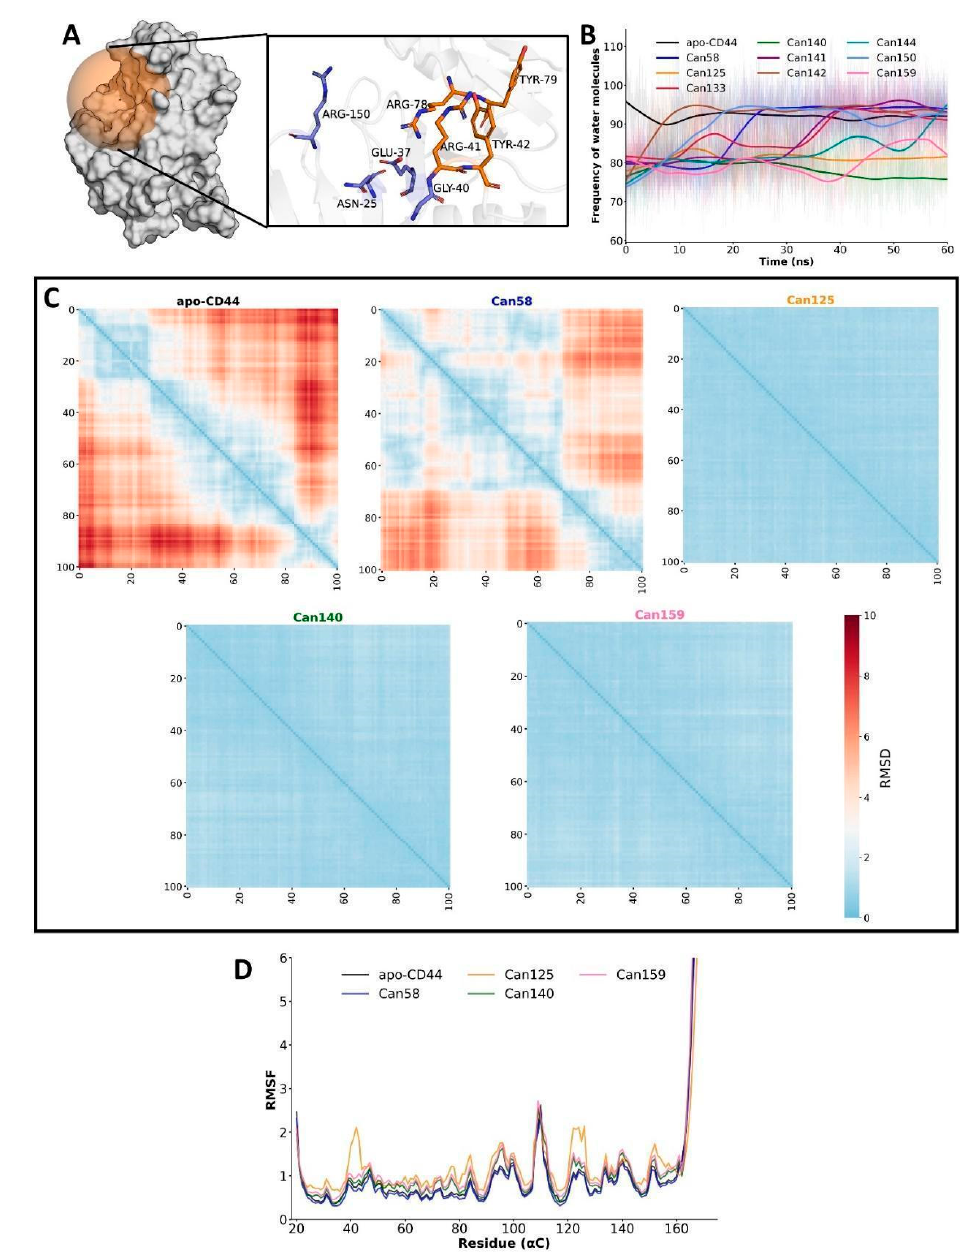
Figure 4. Molecular dynamics (MD) analysis identified Can 125 as a potential CD44 antagonist. ( A ) Spatial representation of the analyzed pocket in hCDHAbd. Inset shows the lateral chains of residues reported as essential for HA-binding (orange sticks) or those that mediate the interaction with the THQ-containing compounds employed for pharmacophore modeling (blue sticks). ( B ) Water molecules displacement analysis for the nine candidates shown in Figure 3D. ( C ) Pairwise backbone RMSD matrix along 100 ns of MD simulation from systems including candidates with stable binding to hCD44HAbd. The unliganded protein (apo-CD44) and the system with Can58 are included for comparison. ( D ) Alpha-carbon RMSF analysis for the systems presented in C .